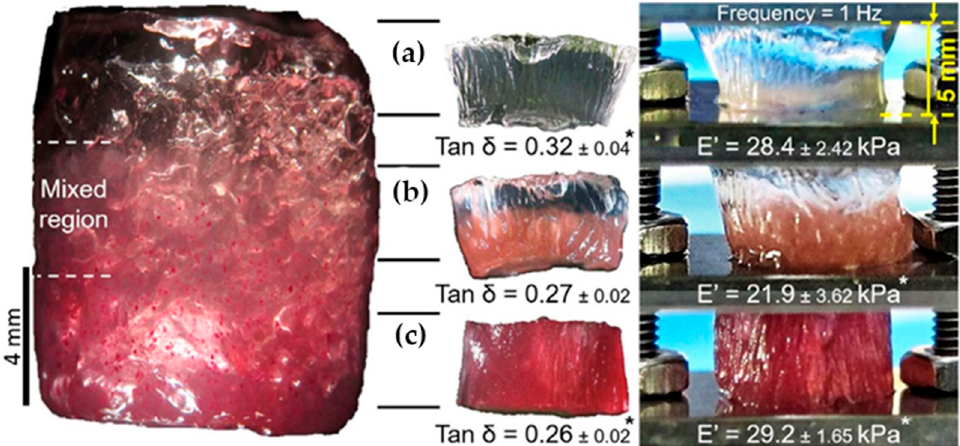
Figure 8. The dynamic mechanical behavior of ( a ) top, ( b ) middle and ( c ) bottom regions of gradient hydrogels together with Young’s moduli and phase angles [17].